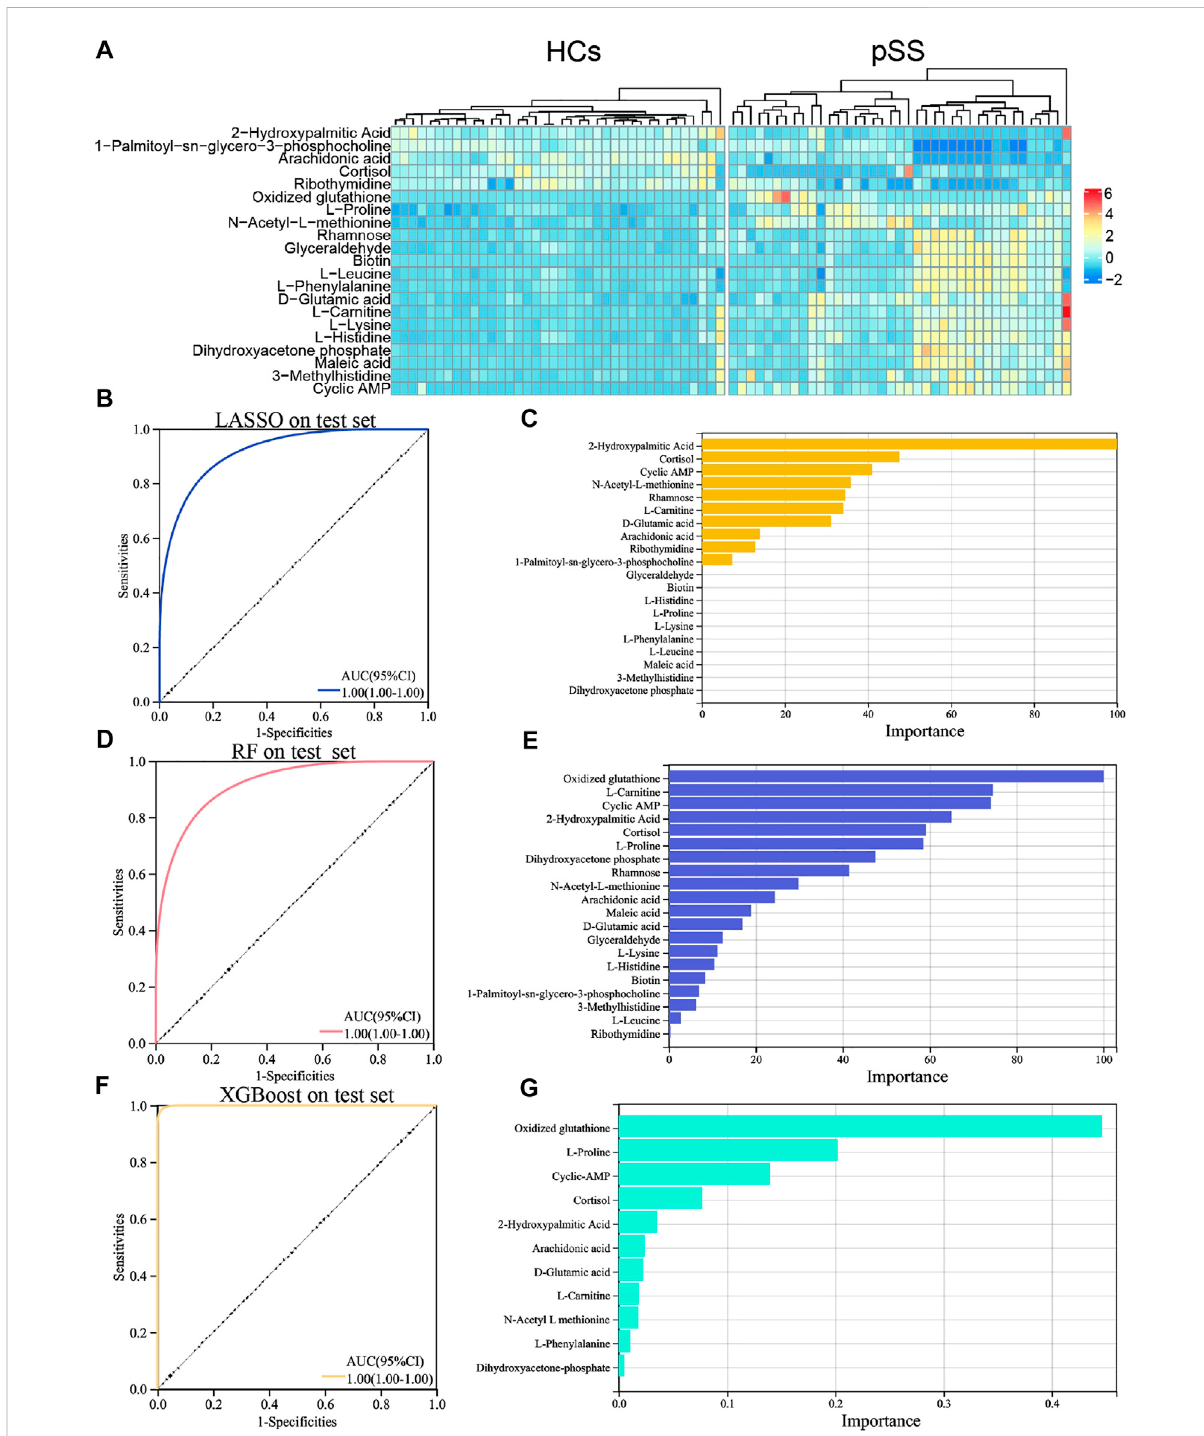
FIGURE 3 Heat map, ROC curve and important variables screening of machine learning algorithms in signi fi cantly different metabolites. Heat map of metabolites with signi fi cant differences in pSS group and HCs group (A) . ROC curve of LASSO model in 21 signi fi cantly different metabolites on the test set (B) . Important variable screening of LASSO (C) . ROC curve of RF model in 21 signi fi cantly different metabolites on the test set (D) . Important variable screening of LASSO (E) . ROC curve of XGBoost model in 21 signi fi cantly different metabolites on the test set (F) . Important variable screening of XGBoos (G)